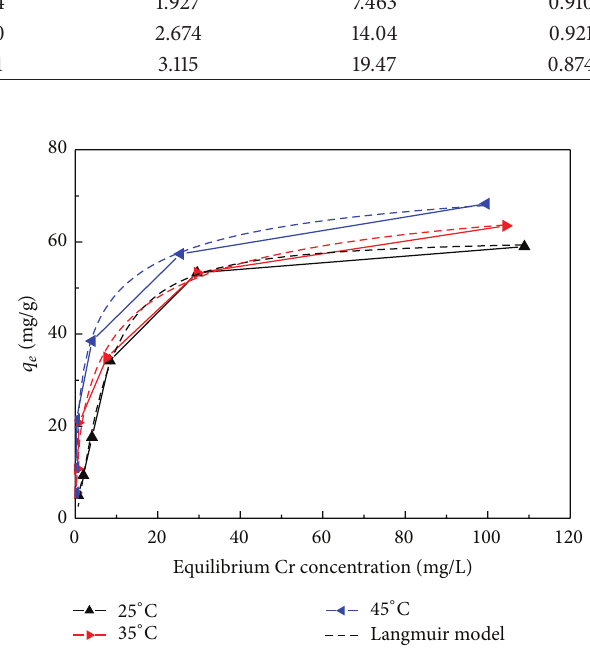
Figure 7: Adsorption isotherms at 25 ∘ C, 35 ∘ C, and 45 ∘ C of Cr(VI) on NH 2